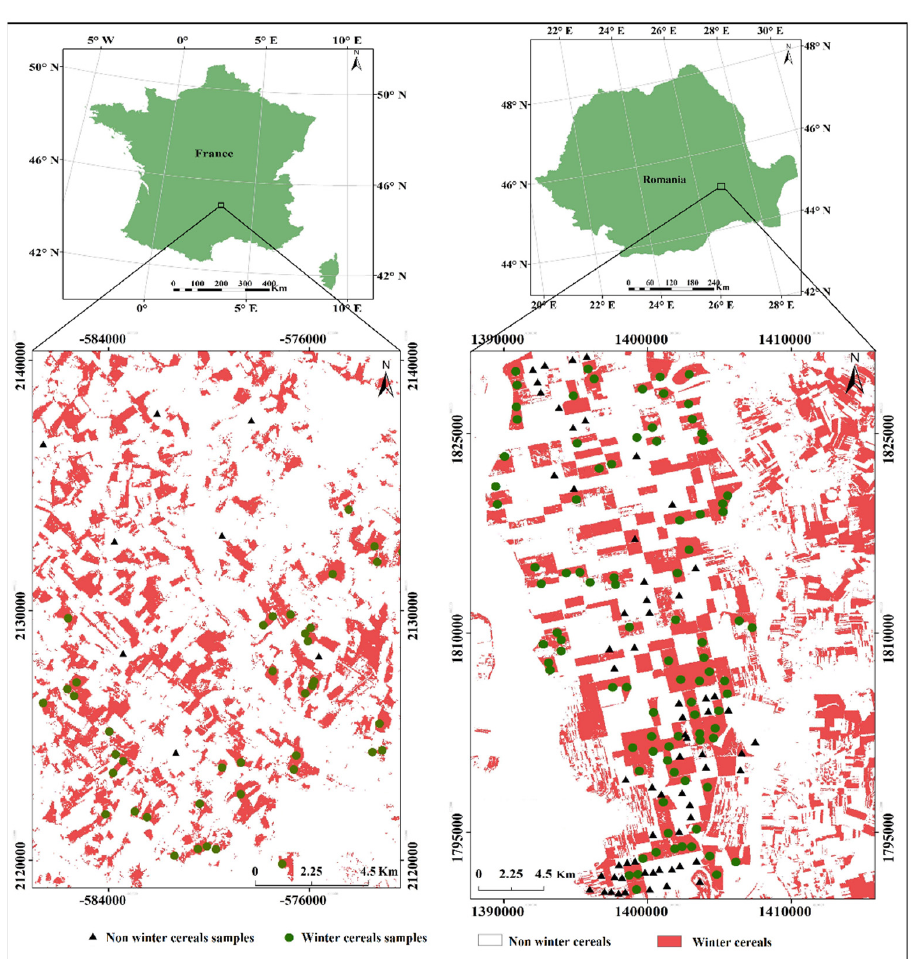
Figure 7. Two examples of pixel-based category maps constructed using the TWDTW method for France and Romania in 2018. Table 2. The confusion matrix of the final winter cereal maps for 32 countries in Europe in 2018.